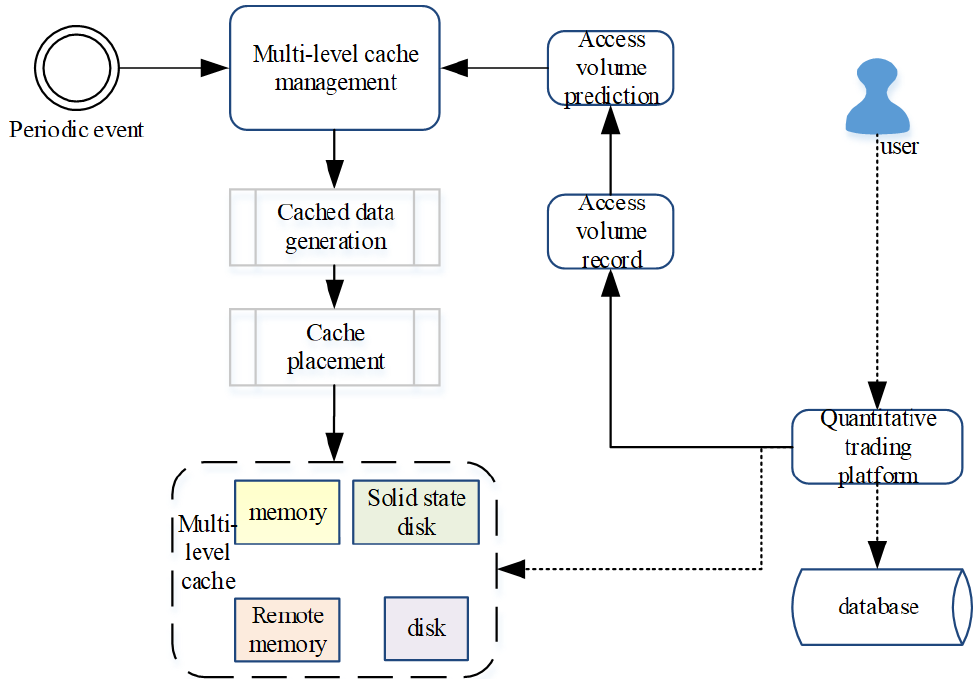
Fig. 2 The framework of multi-level cache